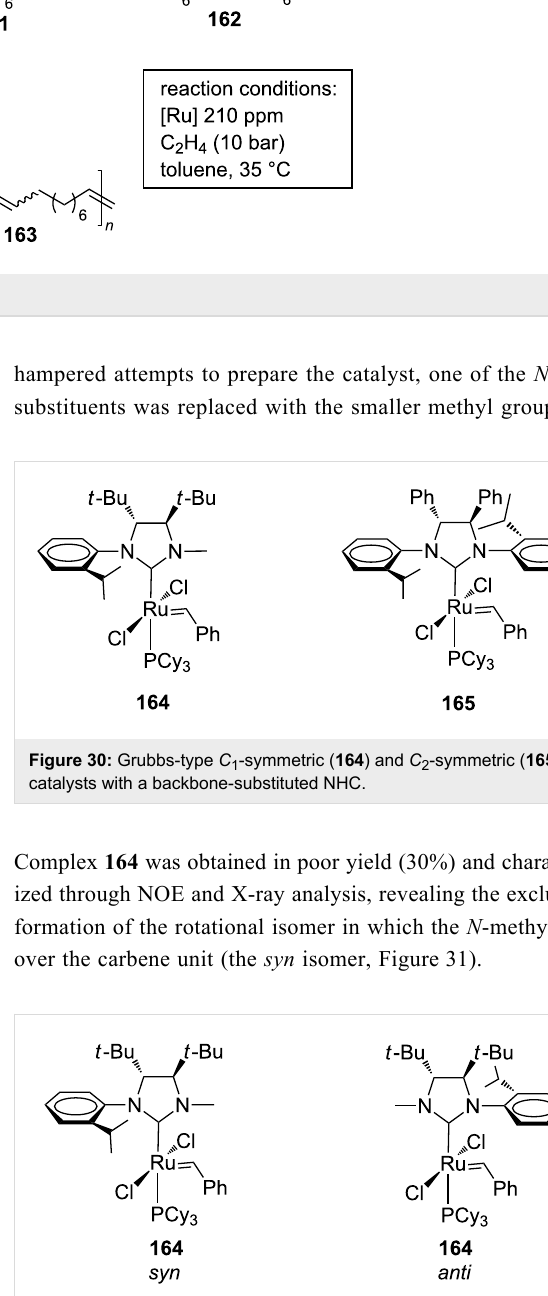
Figure 31: Possible syn and anti rotational isomers of catalyst 164 .